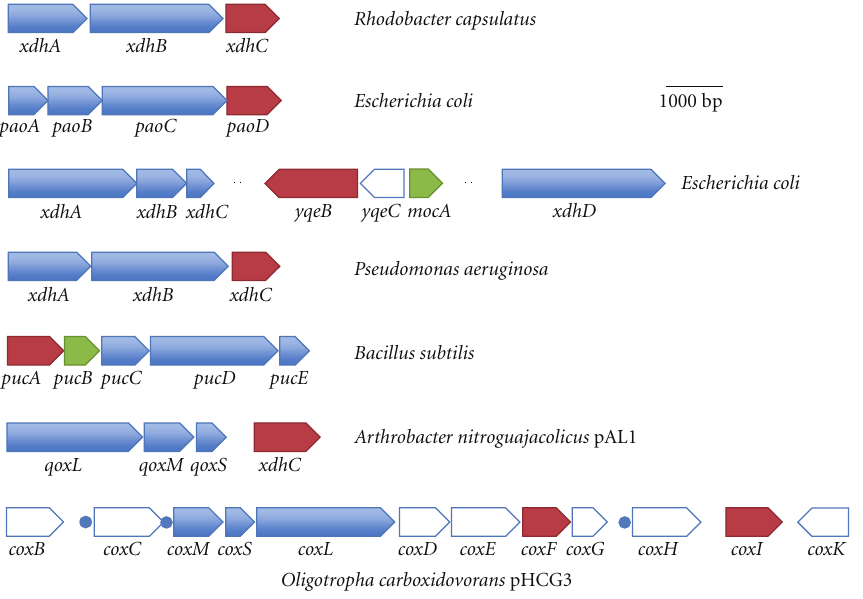
Figure 3: Schematic overview and organisation of operons including xdhC -like genes. Shown is the operon organization of di ff erent operons encoding for molybdoenzymes of the xanthine oxidase family of di ff erent bacteria. Operons of characterized molybdoenzymes are marked in blue, highlighted in red are the predicted genes encoding XdhC homologues, marked in green are genes for putative MocA-homologues, and marked in white are open reading frames encoding proteins with di ff erent (or not assigned) roles. In the operon structure encoding for the CODH, blue dots indicate predicted promoter sequences as published by Santiago et al.